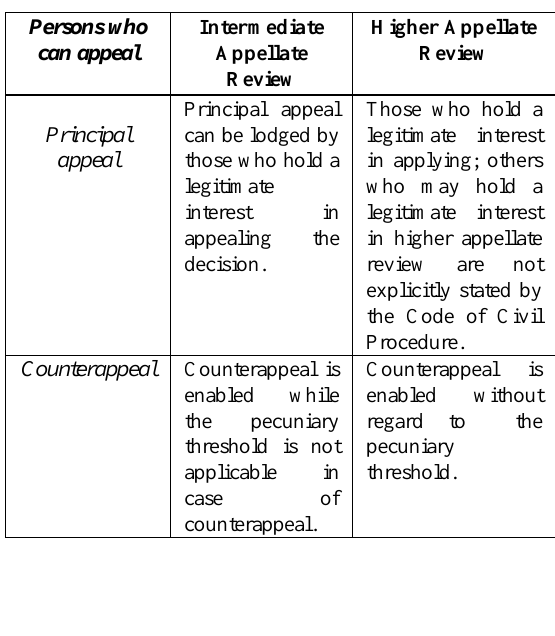
Table 3. Parties to the Intermediate Appellate